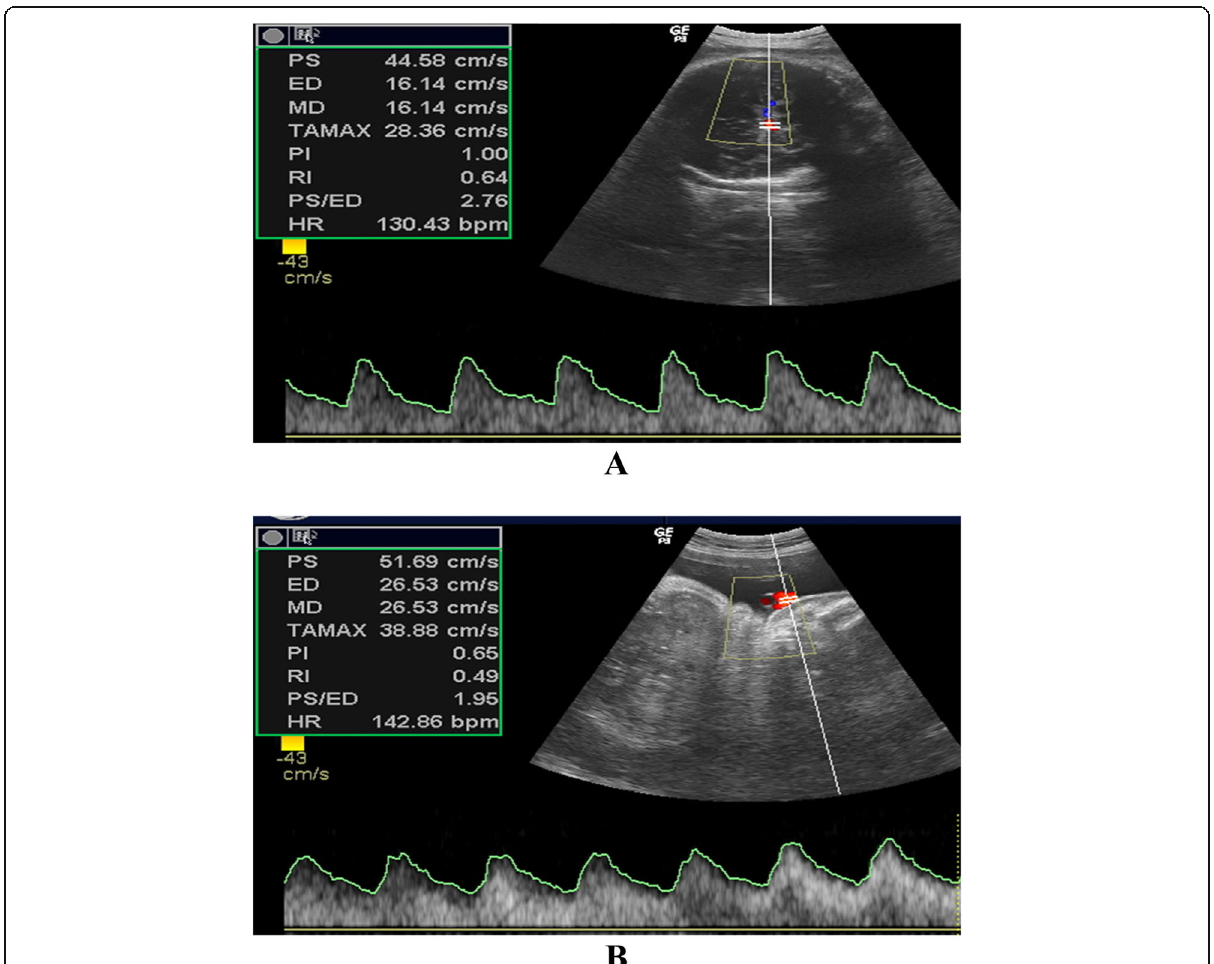
Fig. 7 Normal Doppler imaging of MCA and UA at 40 weeks of gestational age in a 25-year-old female mother. FHR, 136 b/m; placenta grade III; and EFW, 3100 g. a Doppler US examination of fetal MCA revealed PSV = 44.58, S/D = 2.76, RI = 0.64, and PI = 1.00. b Doppler US examination of maternal UA revealed PSV = 51.69, S/D = 1.95, RI = 0.49, and PI = 0.65. CPR Doppler values: PSV = 0.86, S/D = 1.41, RI = 1.31, and PI =